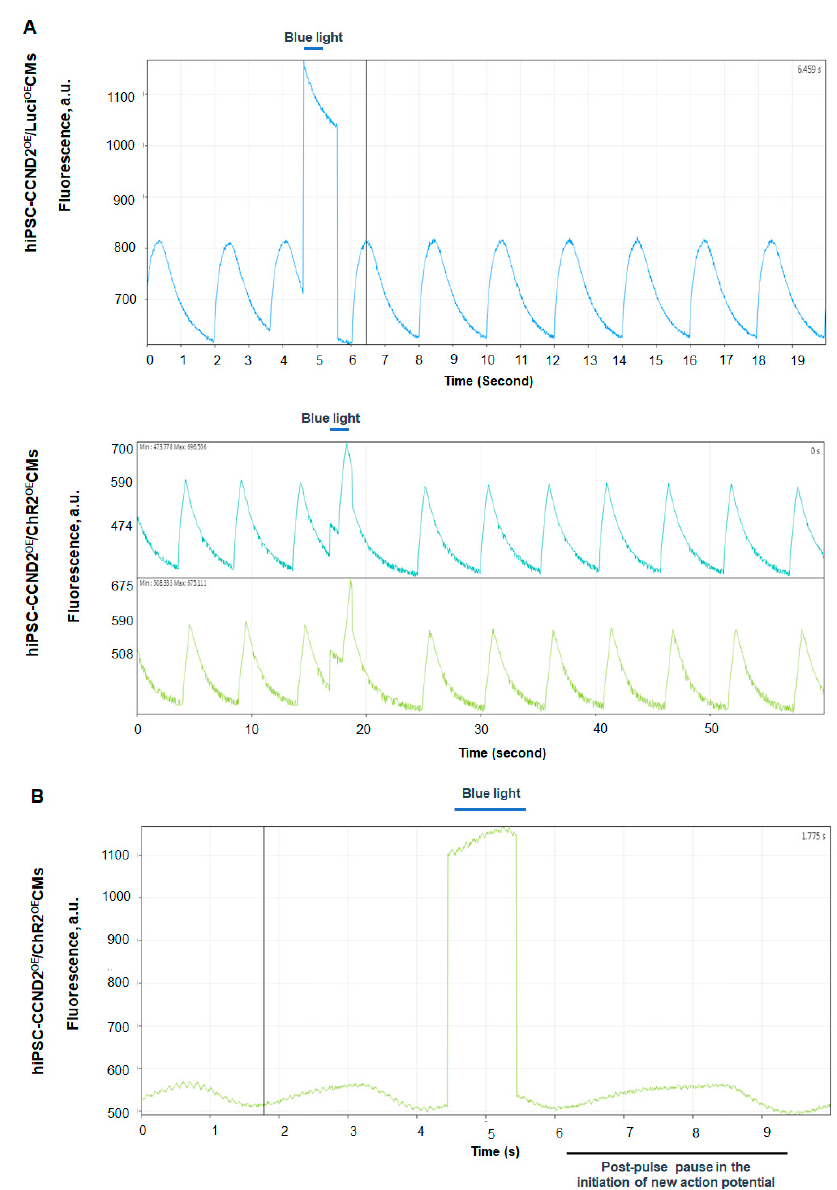
Figure 4. Light-induced changes of calcium transients and action potential of hiPSC-CMs in vitro. ( A ) Calcium mapping. Spontaneous calcium transients in hiPSC-CCND2 OE /Luci OE CMs (upper trace) and hiPSC-CCND2 OE /ChR2 OE CMs (middle and bottom traces). Blue light illumination (1 s) did not alter rhythmicity of calcium transients in the hiPSC-CCND2 OE /Luci OE CMs, whereas it delayed the subsequent cycle in hiPSC-CCND2 OE /ChR2 OE CMs. ( B ) Voltage mapping. Spontaneous action potentials in hiPSC-CCND2 OE /ChR2 OE CMs. Since RH-237 fluorescence decreases with depolarization, the peak and trough fluorescence intensities correspond to the maximal diastolic potential and peak action potential amplitude, respectively. Blue light illumination delayed the onset of the subsequent cycle. Contamination of the fluorescence signals by the blue excitation light prevents their proper interpretation during illumination.